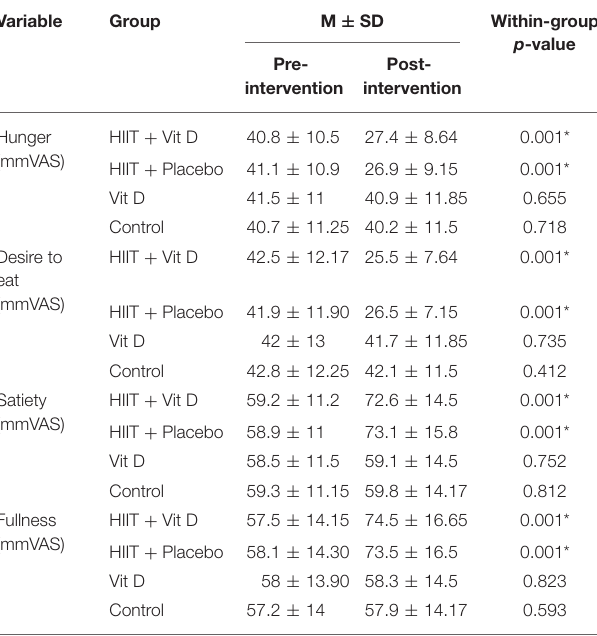
TABLE 4 | Comparison of appetite between groups after the